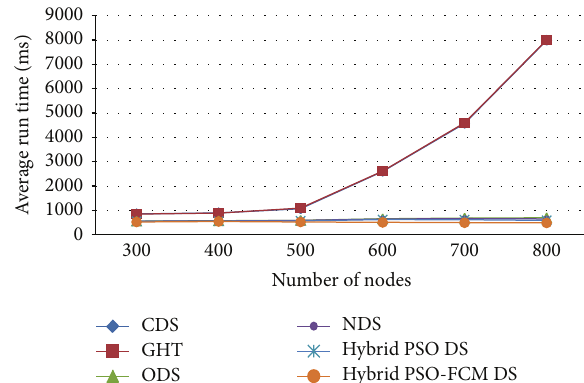
Figure 4: Energy consumption with number of consumers.